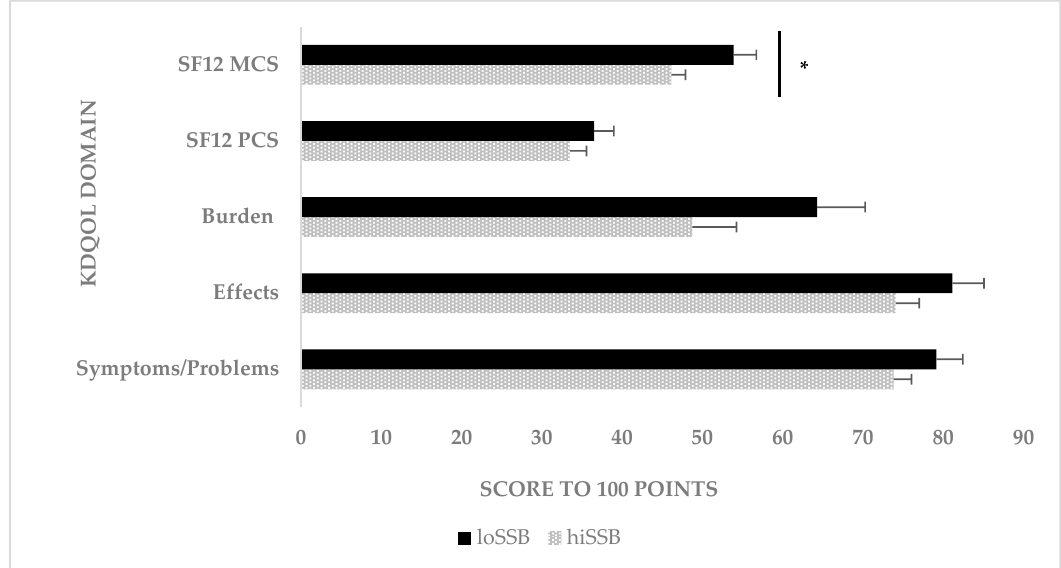
Figure 1. KDQOL scores according to diet cluster. SF 12 MCS: short form mental component summary; SF 12: short form physical component summary. Data is presented as means ± SEM. In comparison with patients consuming a loSSB pattern, those consuming a hiSSB pattern reported lower baseline KDQOL scores across all five domains and significantly lower baseline KDQOL scores for the S12 mental composite subscale. hiSSB, n = 20; loSSB, n = 28. Data were compared using a Mann–Whitney U test with a * p < 0.05 considered